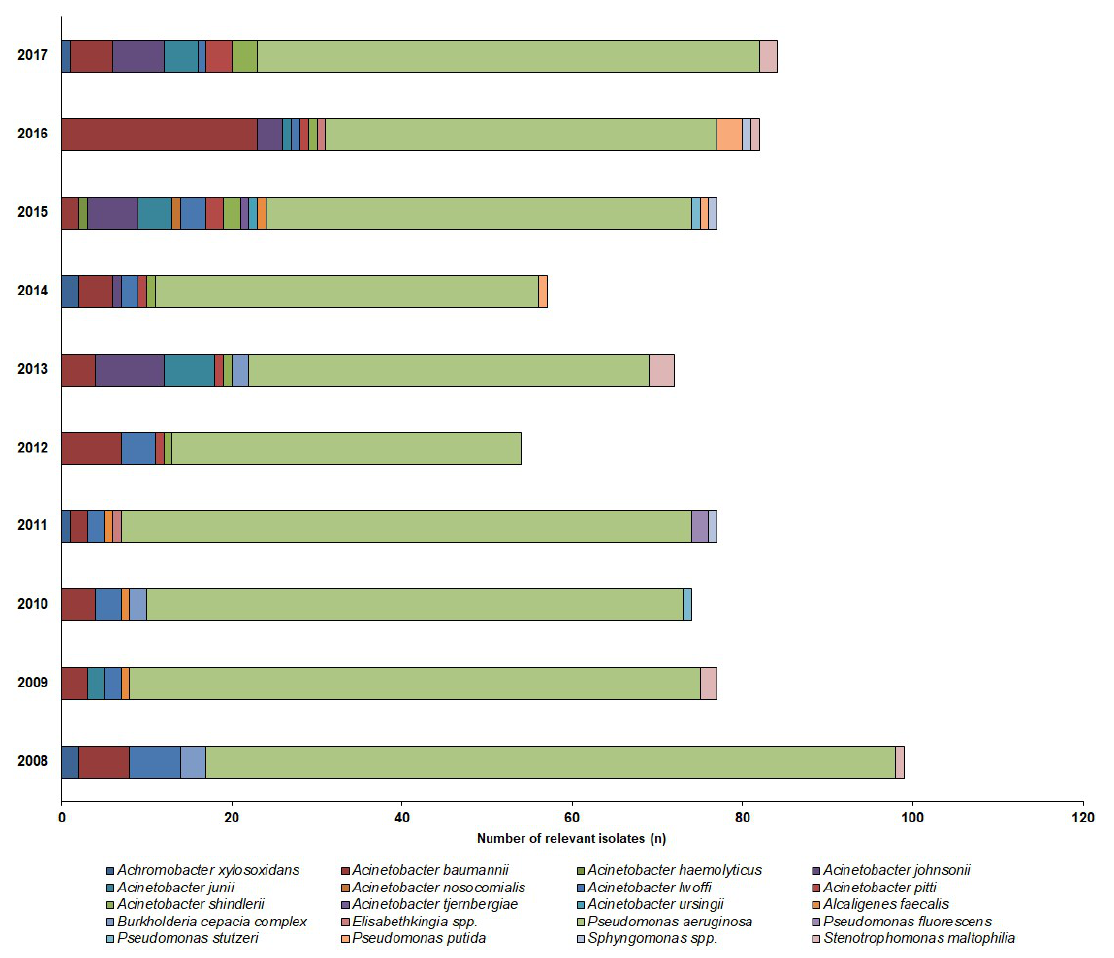
Figure 3. Frequency and species distribution of non-fermenting Gram-negative bacterial (NFGNB) isolates in the inpatient samples (2008—2017).